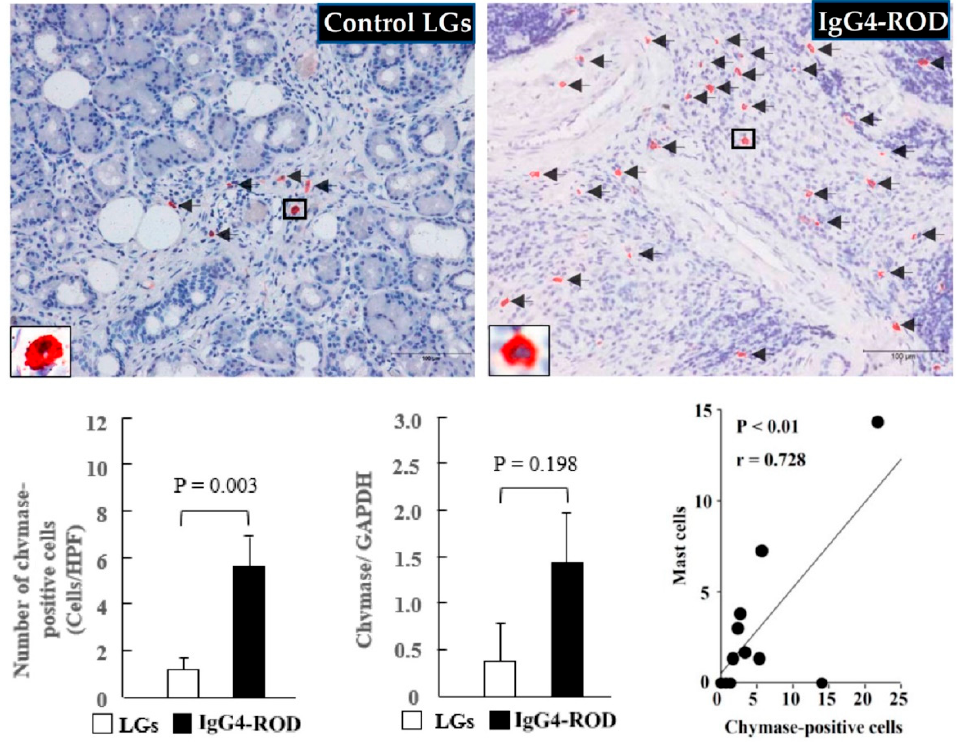
Figure 5. Representative images of chymase immunostaining, the chymase-positive cell population, and the chymase expression of the LGs obtained from the patients with IgG4-ROD and from the control patients diagnosed with severe canalicular obstruction yet with no IgG4-ROD. Black arrows indicate chymase-positive cells. Bar graphs show the quantitation of the chymase-positive cell numbers and the chymase expression between the two groups. Line graph shows the linear regression analysis between the numbers of chymase-positive cells and MCs in all data of the examined LGs.